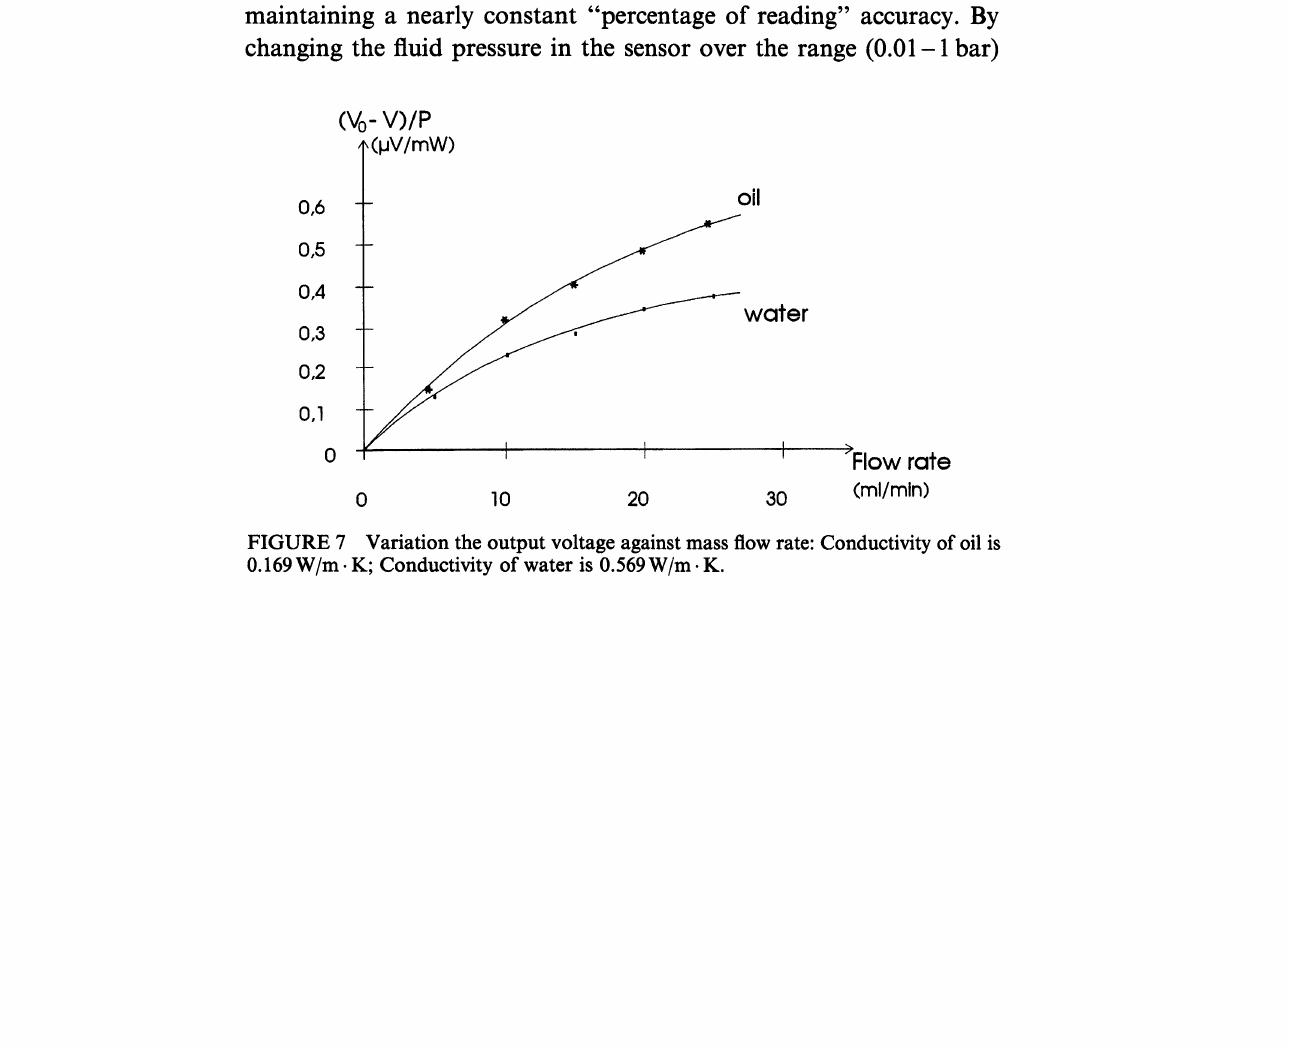
FIGURE 7 Variation the output voltage against mass flow rate: Conductivity of oil is 0.169 W/m. K; Conductivity of water is 0.569 W/m.